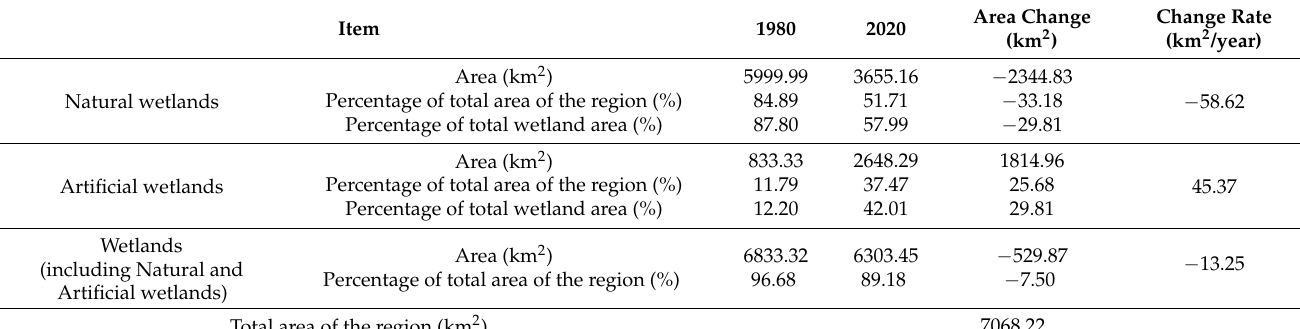
Table 2. The area change statistics of the coastal wetland in northern Jiangsu during 1980–2020.